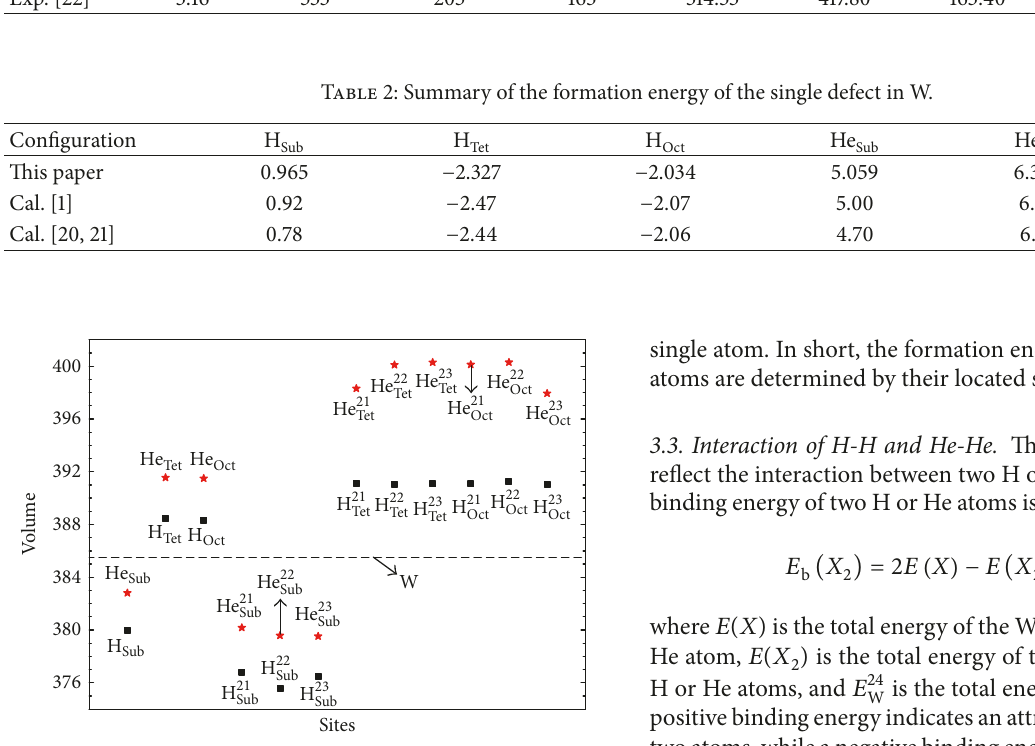
3 Figure 3: The volume (in ˚A ) of the supercell ( 2 × 3 × 2 ) of the W supercell with single and two point defects formed by H and He atoms. The dashed line represents the volume of the perfect BCC W supercell.